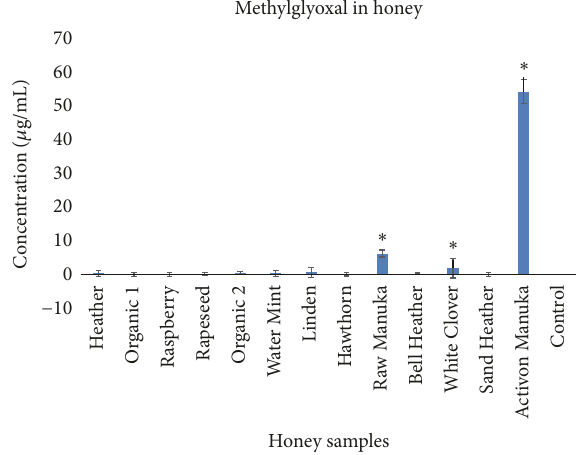
For S. epidermidis, comparable results were observed with Raspberry ( R. odoratus ), Hawthorn ( C. monogyna ), and